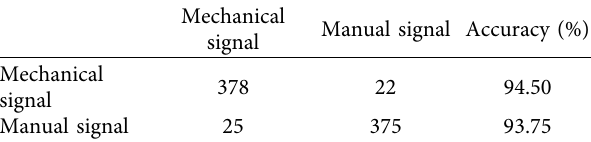
Table 4: TSVD-SCN network recognition